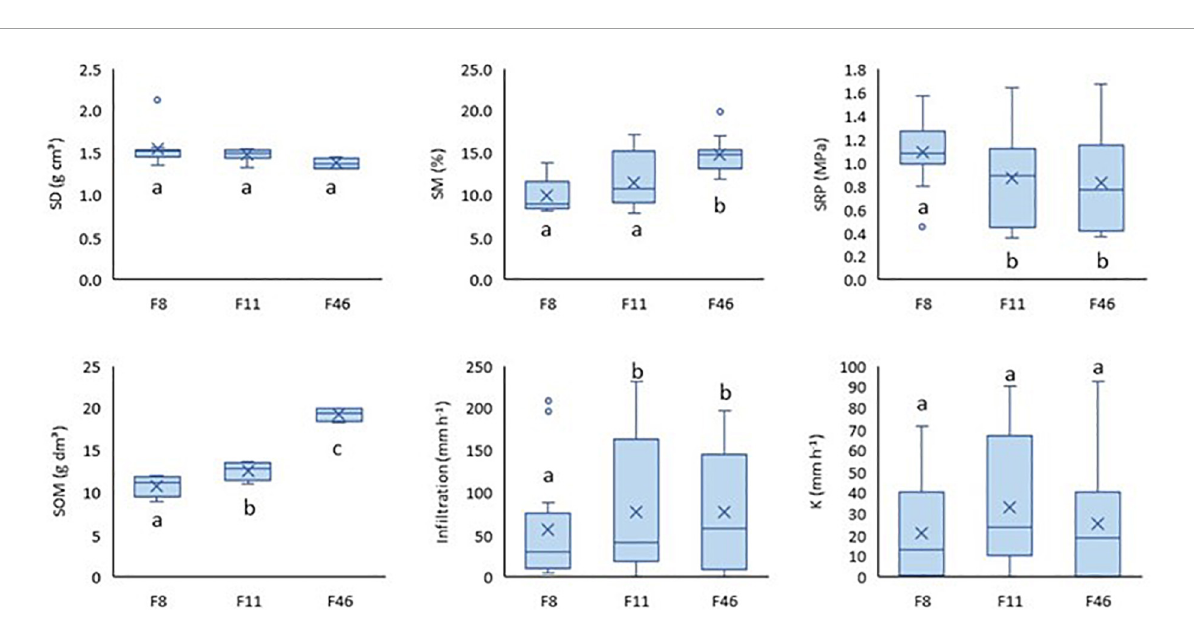
FIGURE3 Annual soil density (SD), soil moisture (SM), soil resistance penetration (SRP), soil organic matter (SOM), infiltration (IR), and soil conductivity